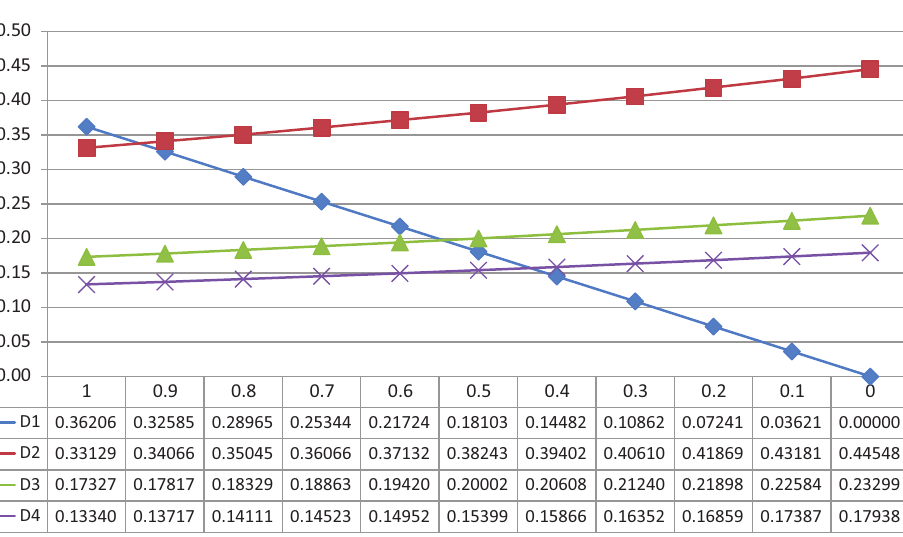
Figure 7. Results of the sensitivity analysis for the factor Traffic Management Tools and